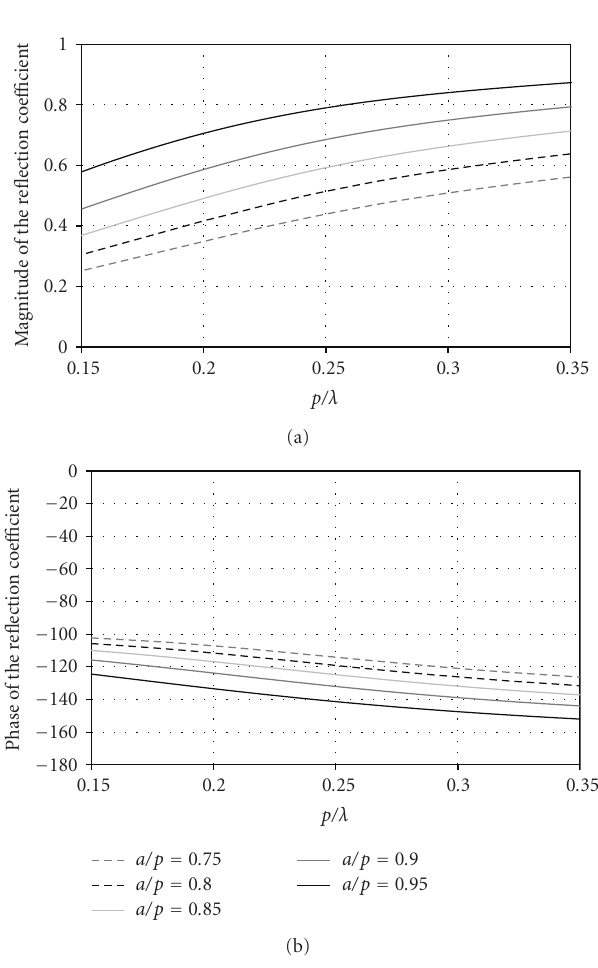
Figure 6: Reflection coe ffi cient of the FSS.